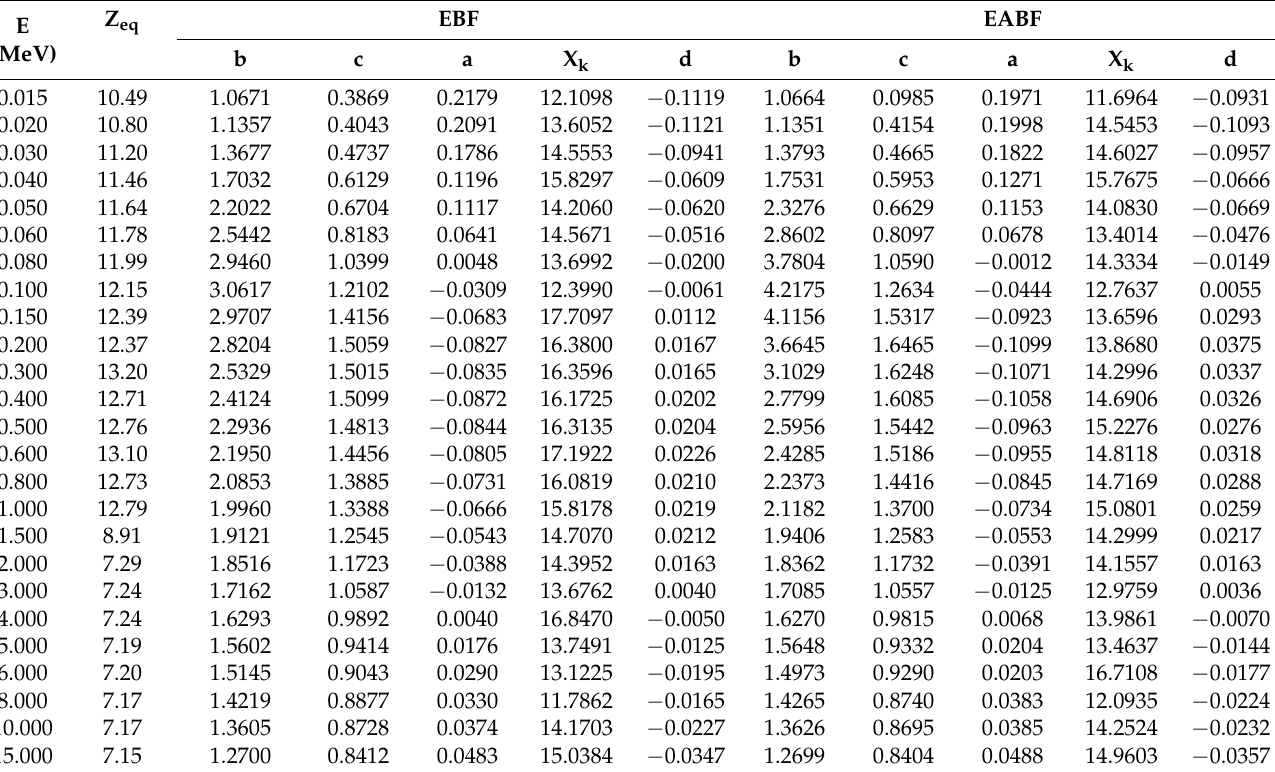
Table 4. (EBF and EABF) G–P fitting coefficients (b. c. a. X k and d) of CuZn05